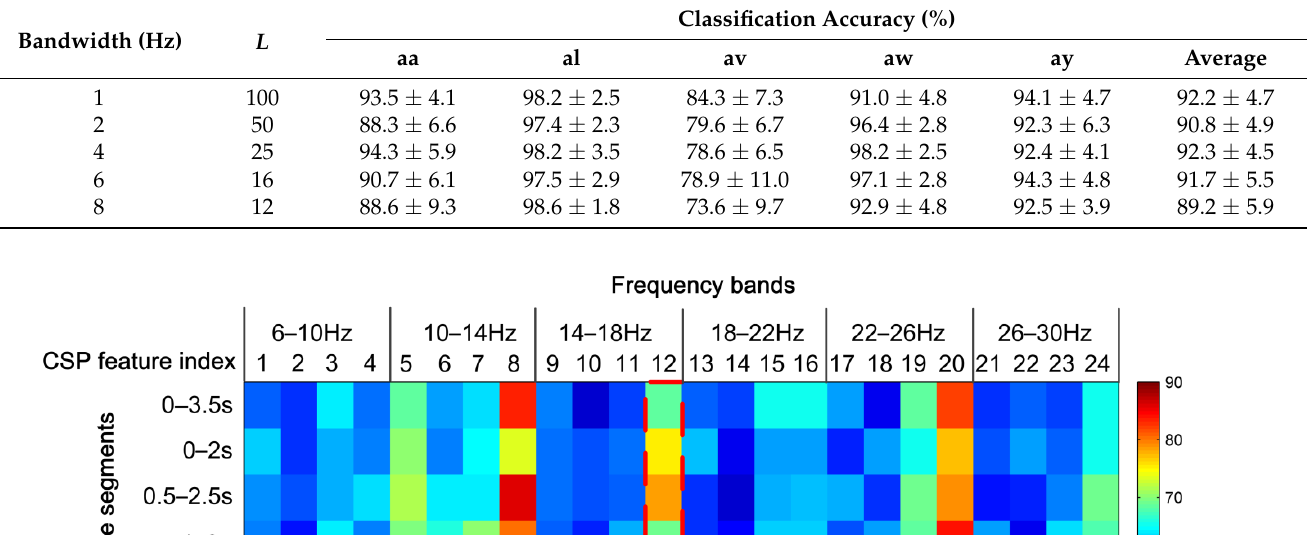
Table 3. The classification accuracies of CiSSA + CSP methods on different bandwidths on BCI Competition III dataset IVa (subject aa, al, av, aw, and ay).